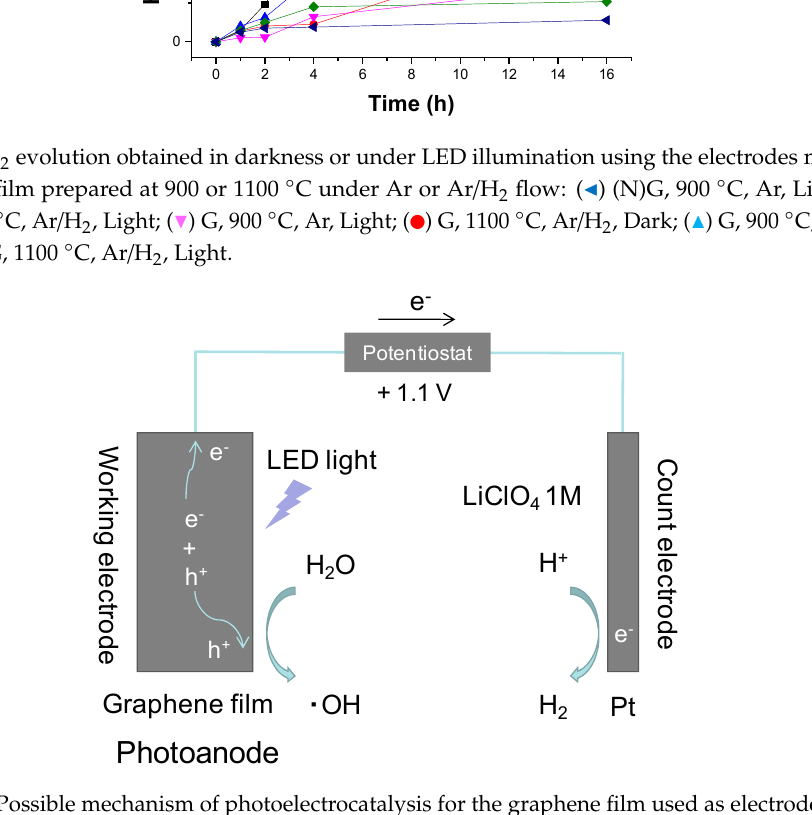
Scheme 3. Possible mechanism of photoelectrocatalysis for the graphene film used as electrode under LED illumination with a positive 1.1 V applied bias. The test was performed using an aqueous solution of 1 M LiClO 4 as electrolyte, a Pt foil as counter electrode, and Ag/AgCl as reference electrode.